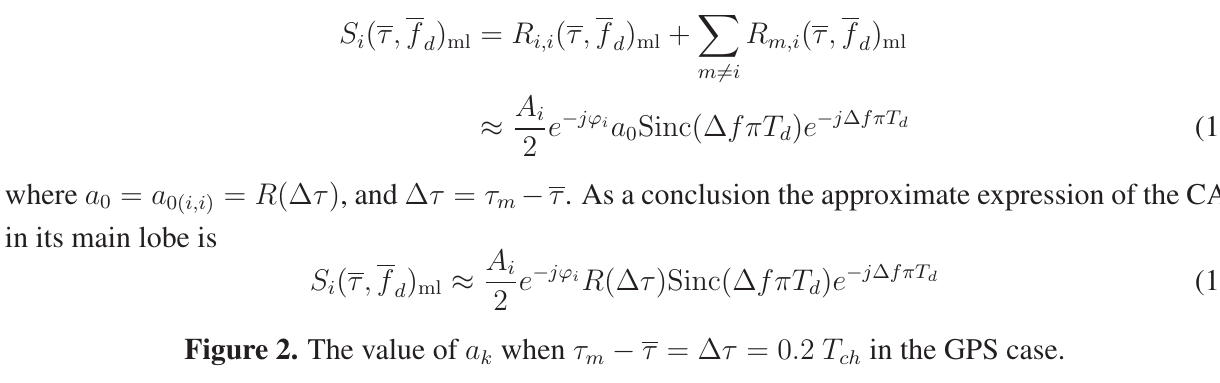
Figure 2. The value of a k when τ m − τ = Δ τ = 0 . 2 T ch in the GPS case.